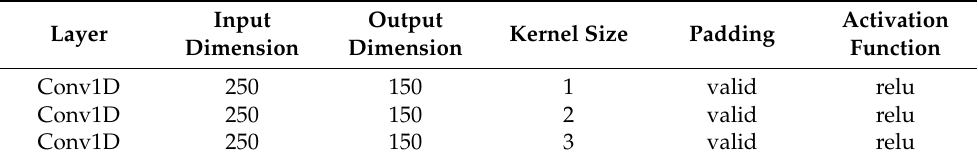
Table 5. CNN Layered